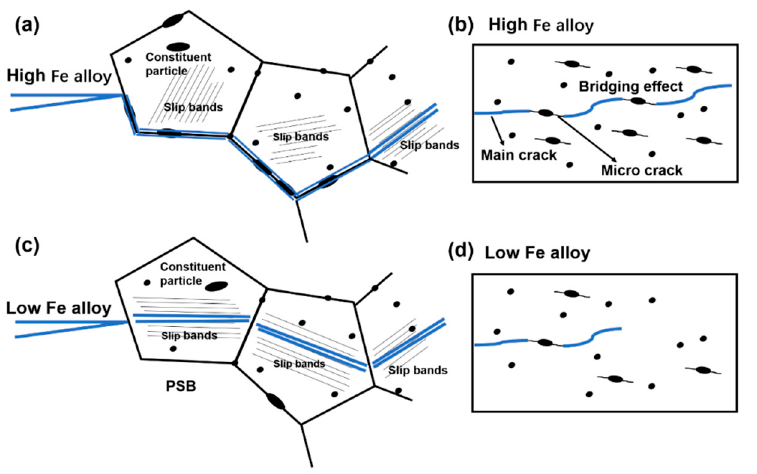
Figure 14. Schematic diagrams illustrating the effect of the constituent particles on the fatigue crack growth (FCG) behavior in ( a , c ) High Fe and ( b , d ) Low Fe